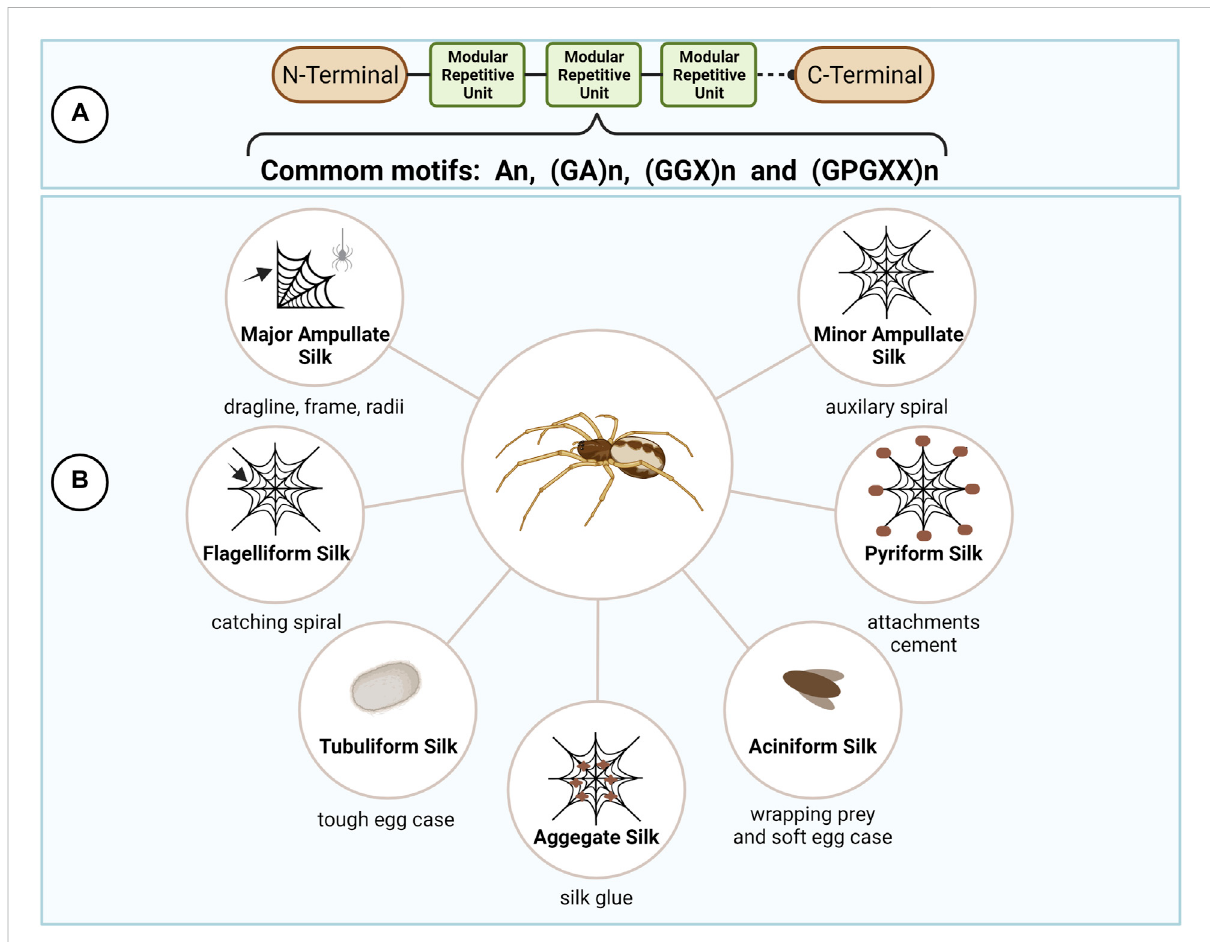
FIGURE 2 Spider silks types and protein structure. Spider silk proteins (spidroins) are composed by repetitive amino acid motifs fl anked by the highly conserved N- and C- terminal domains (A) . The different combination of the repetitive motifs in the spidroins directly re fl ects their mechanical properties, allowing the production of different kinds of silks for speci fi c tasks in spider ’ s life (B) . This fi gure was created with